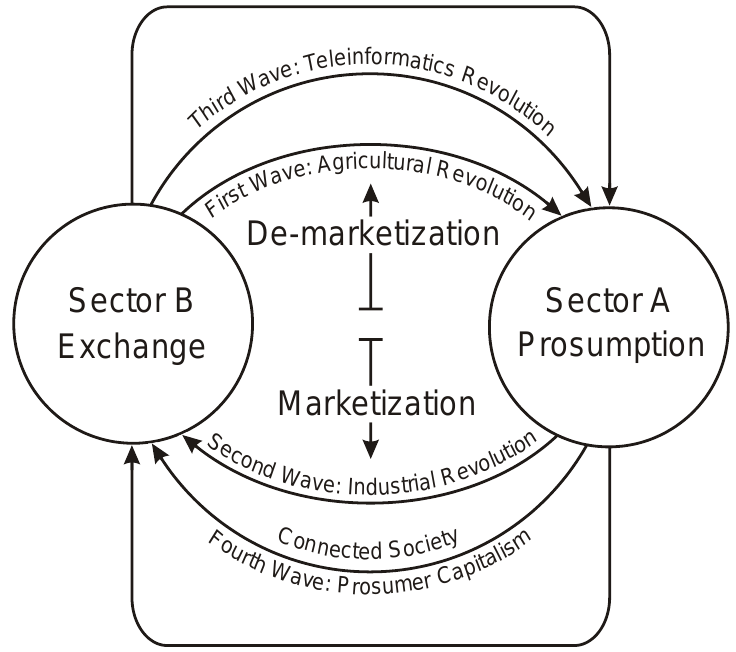
Figure 1. The revised diagram of Toffler’s civilization revolutions.